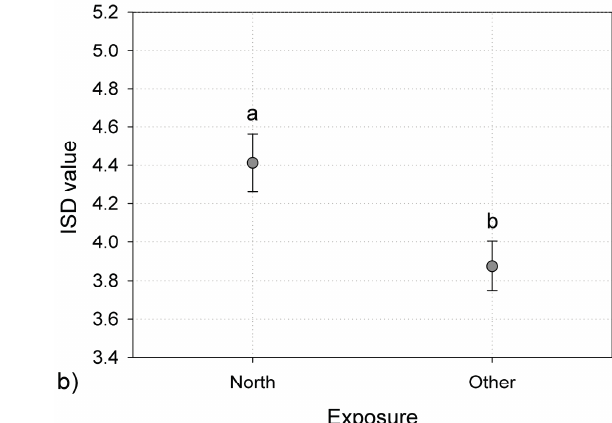
Figure 6. ISD mean values and standard errors of roofs considered in the ANOVA analysis ( n = 60). Data are shown ( a ) grouped according to the year and ( b ) grouped according to the exposure . Results of the Fisher LSD test are reported with different letters.